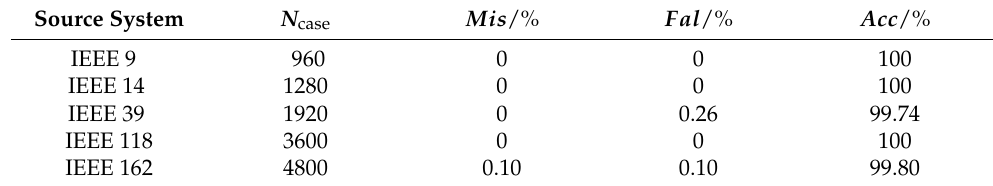
Table 1. Learning Performances of Source TSA Models (with Validation